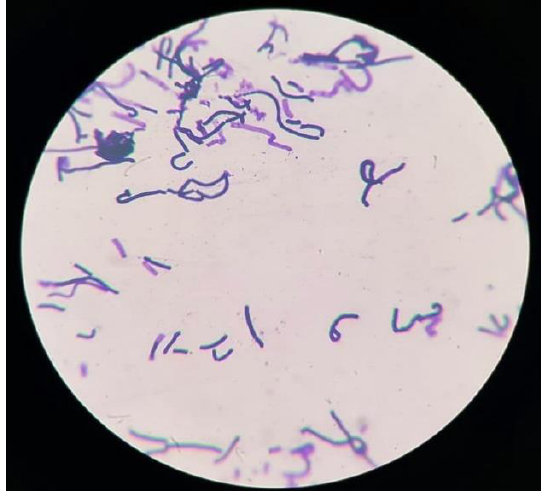
Fig. 2: Arrangement of Corynebacterium spp. by Gram’s stain showing Gram-positive non spore forming pleomorphic bacilli (100×) (V- shaped, L-shaped, palisade and Chinese letter).